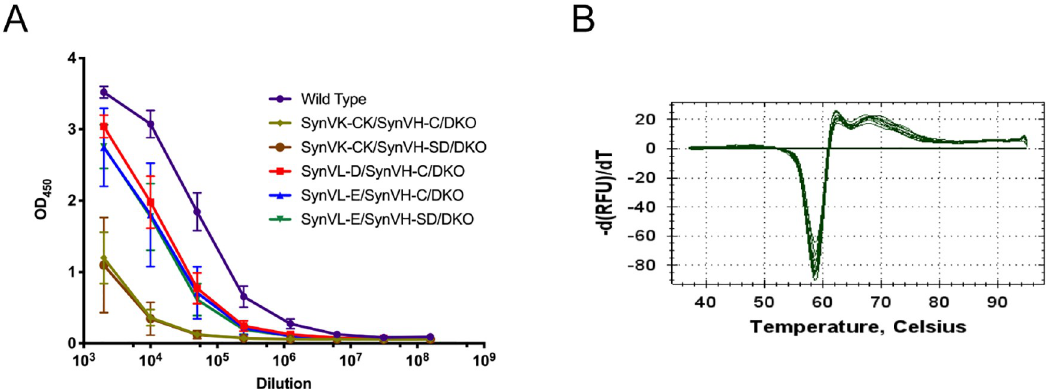
Fig 2. Evaluation of plasma IgY in V λ OmniChickens compared to wild-type and V κ OmniChickens. (A) Plasma from 5 week old wild-type (n = 5), SynVK-CK/SynVH-C/DKO (n = 4), SynVK-CK/SynVH-SD/DKO (n = 4), SynVL-D/SynVH-C/DKO (n = 4) and SynVL-E/SynVH-C/DKO (n = 7) and SynVL-E/SynVH-SD/DKO (n = 8) was assessed by non-quantitative IgY sandwich ELISA. Plasma was first diluted 1:1000 in buffer, followed by 5-fold serial dilutions. The results shown are representative of three independent experiments. The standard deviation between birds within a given genotype is shown. (B) In a thermal shift assay recombinantly expressed wild-type and transgenic immunoglobulins show no difference in melting temperature. The graph shown is representative of three independent